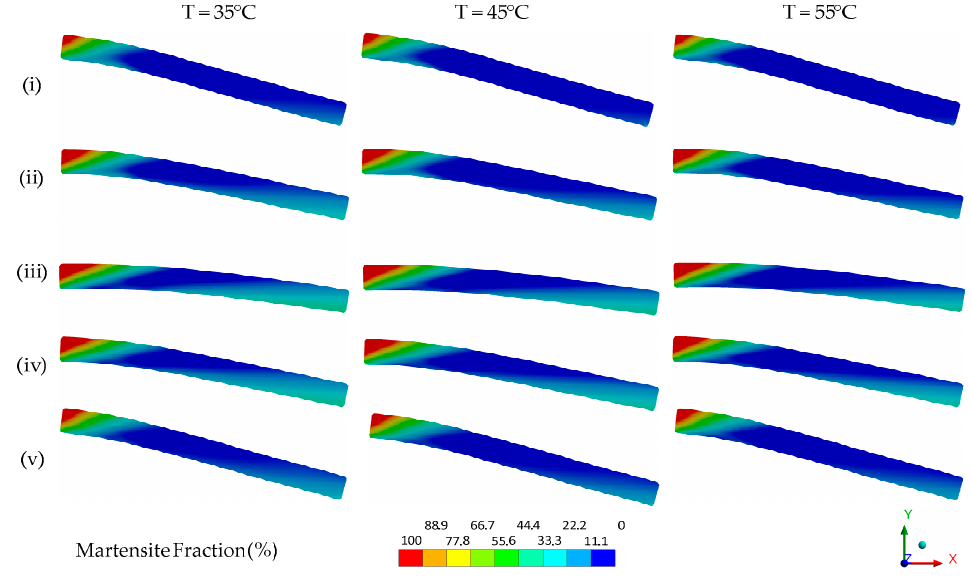
Figure 15. Contour plot of the stress-induced martensite fraction (%) in NiTi Belleville.